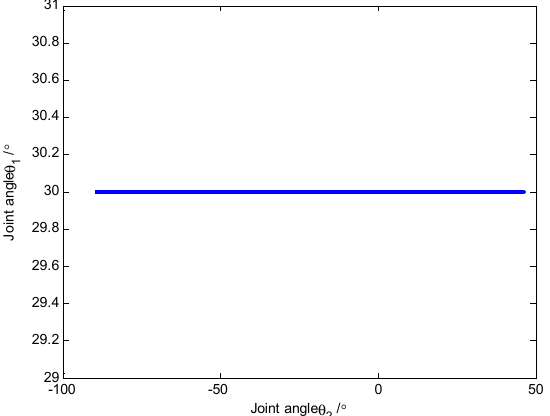
Figure 10. Joint angle θ 2 and θ 3 when M is minimum under different center of gravity heights.